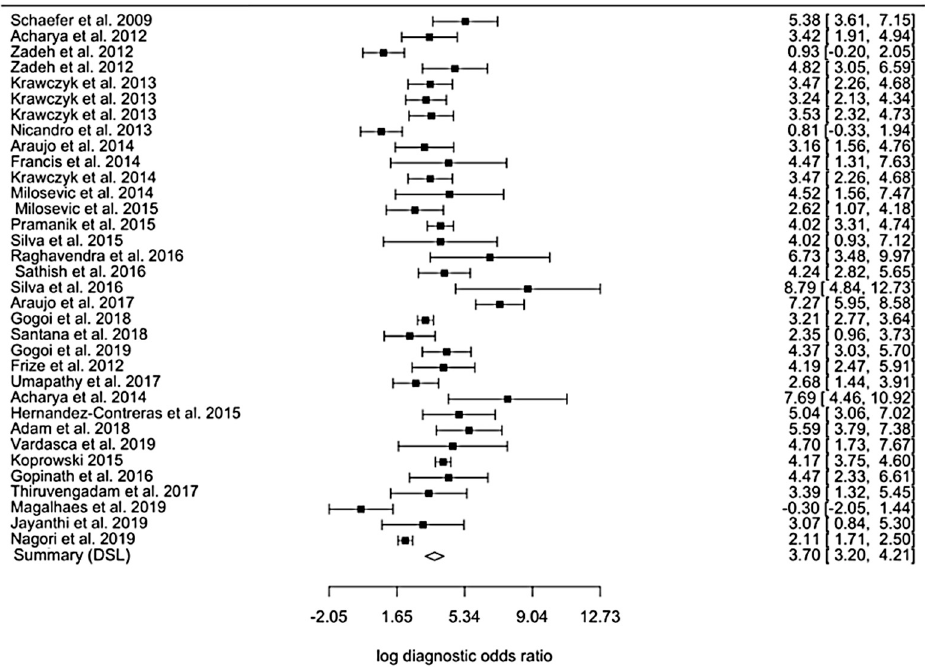
Figure 4. Forest plot for log diagnostic odd ratios: all studies combined.